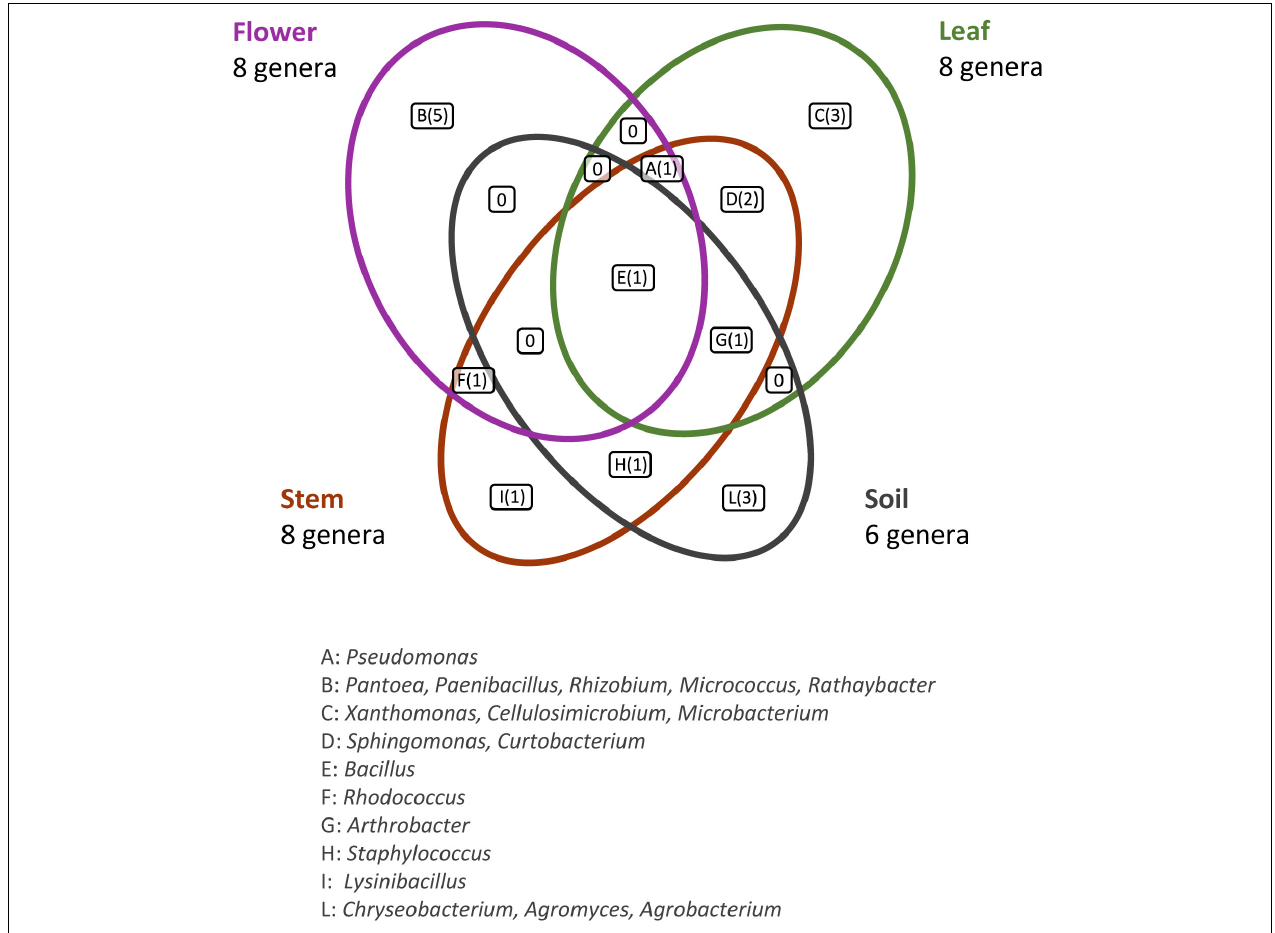
FIGURE 3 | Bacterial genera shared by the different anatomical parts of the plant and in the bulk soil. The number of different genera identified is reported in brackets.